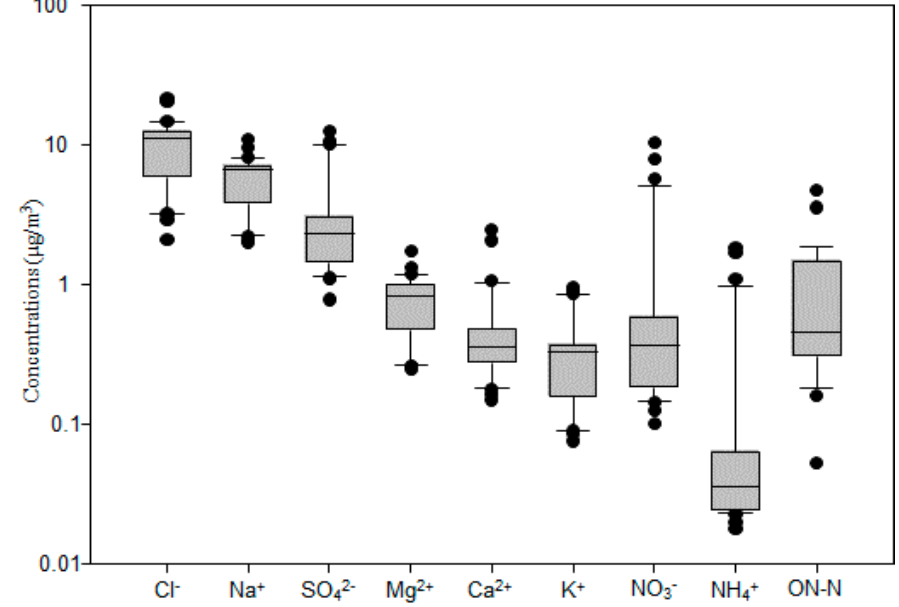
Figure 3. Mass concentrations of aerosol chemical species over the western North Pacific. The boundary of the box indicates the 25th and 75th percentile. The lines within the box mark the mean. Whiskers above and below the box indicate the 90th and 10th percentiles.